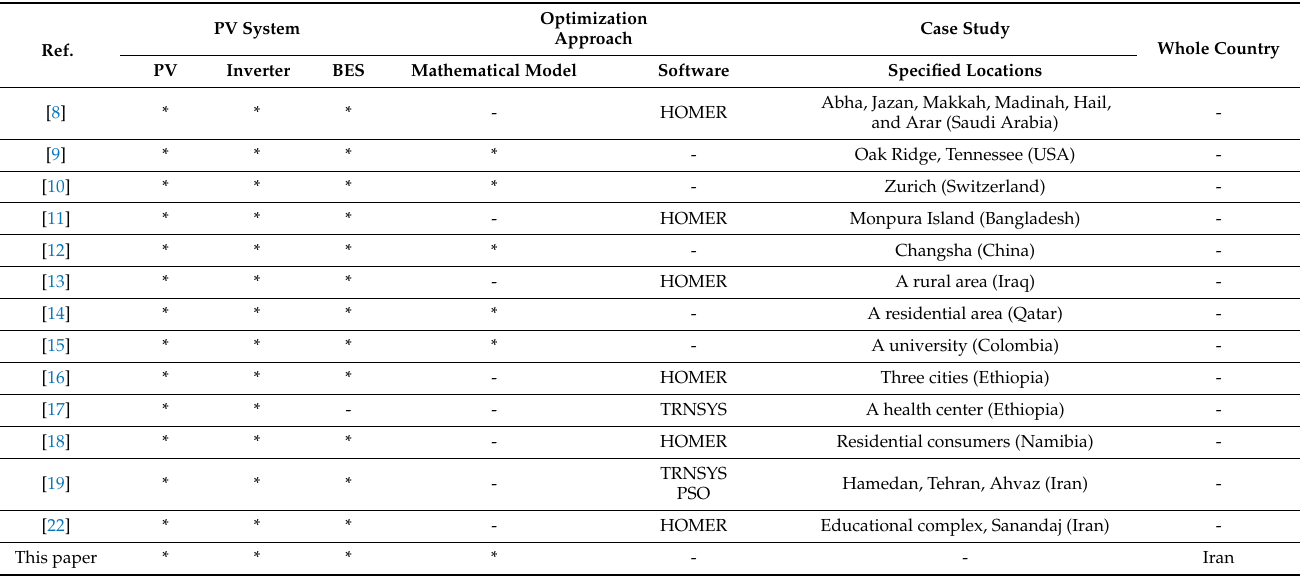
Table 2. Comparing the present paper w previous studies regarding the optimization approaches and case studies.